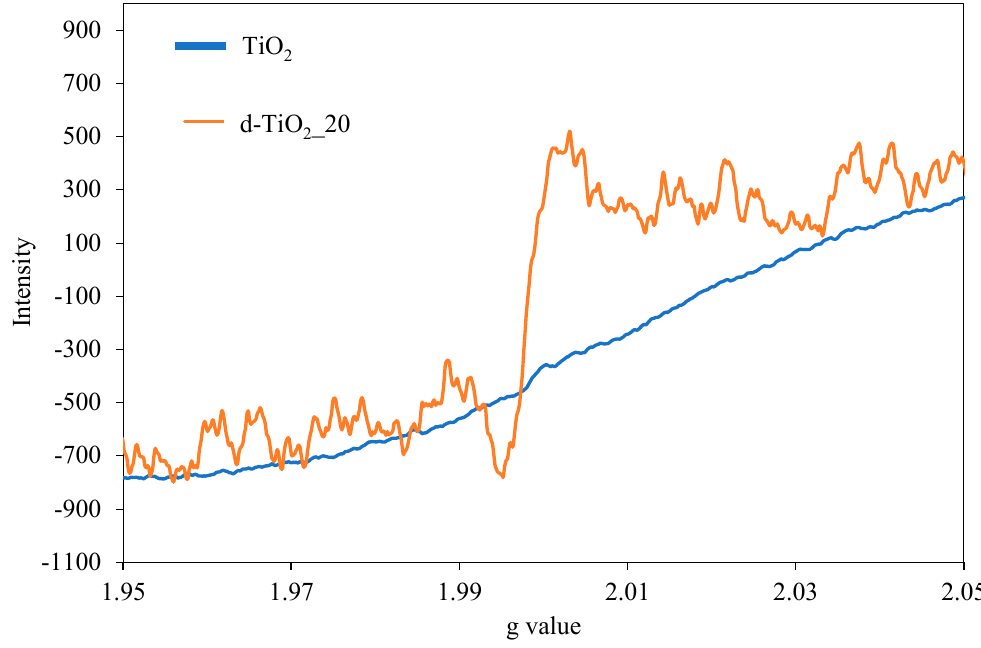
Figure 1. The electron paramagnetic resonance (EPR) spectra in the room temperature for TiO 2 (blue line) and TiO 2 with titania vacancies (orange line).